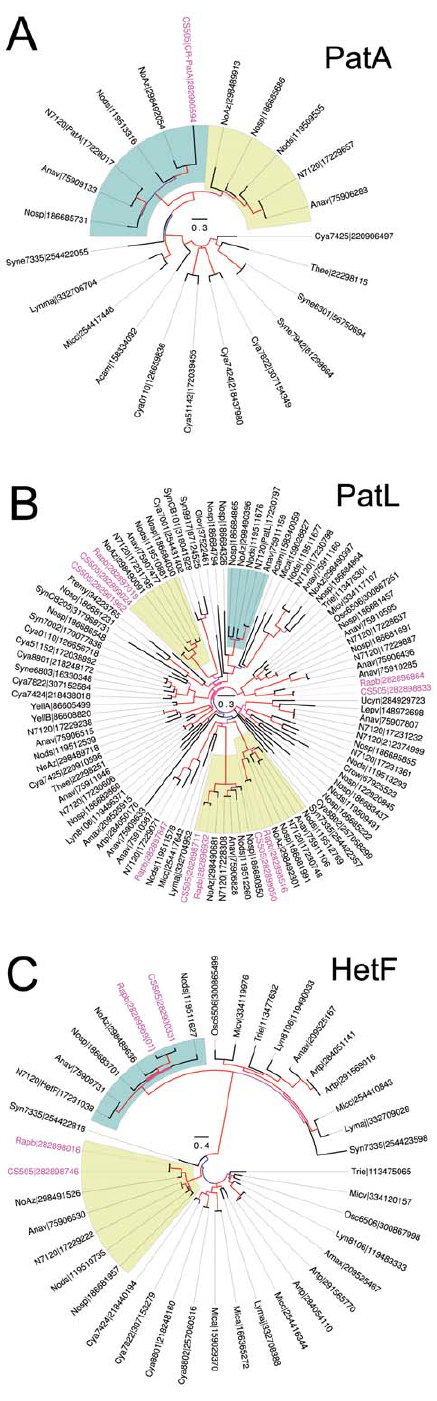
Figure 5. Phylogenetic analysis of PatAL and HetF homologs in C.raciborskii . Maximum-likelihood phylogenetic trees of (A) PatA, (B) PatL, and (C) HetF. Branches are colored by their support value (Shimodaira-Hasegawa test, low [blue] to high [red]). C. raciborskii and R. brookii sequences are colored in pink for clarity. Clades including the canonical heterocyst differentiation proteins are shaded in green while non-canonical heterocystous clades are shaded in yellow. Scale bar shows expected substitutions per site. In (C), the ‘‘[01]’’ suffix for Rapb|28289569 indicates that the sequence is a concatenation of two neighboring ORFs (see Information S1 for details).